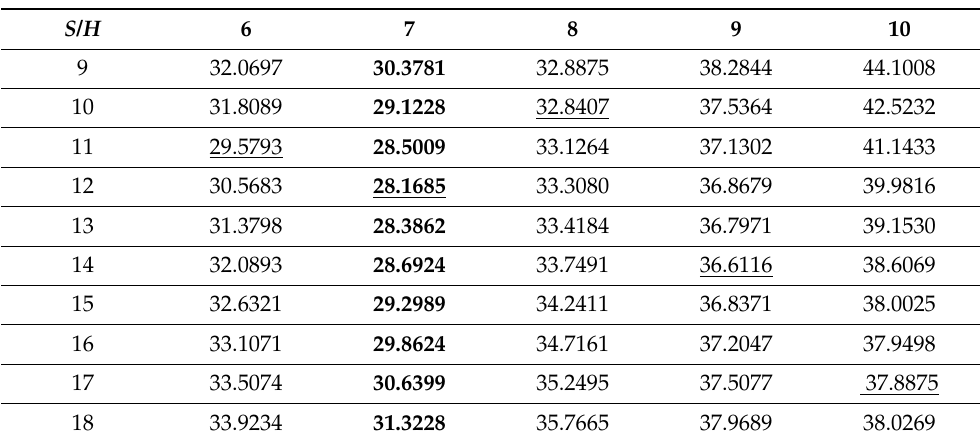
Table 3. Total expected cost rate in terms of S and H